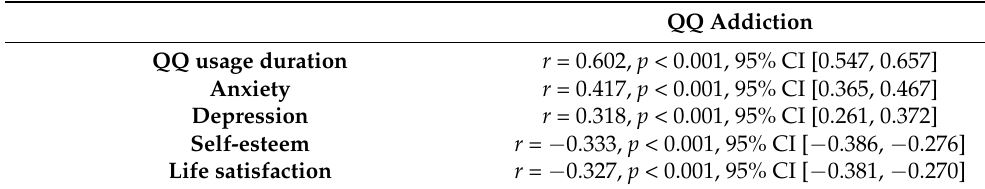
Figure 2. Test information curve of the Problematic QQ Use Scale. Table 5. Correlation coefficients of scores on the Problematic QQ Use Scale with anxiety, depression, self-esteem, and life